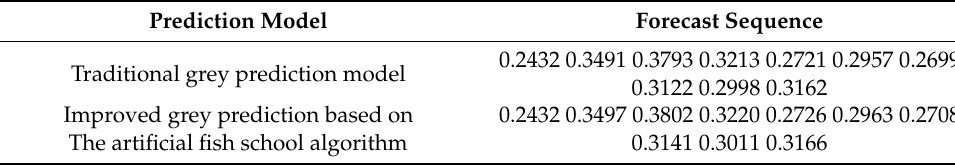
Table 7. Forecast